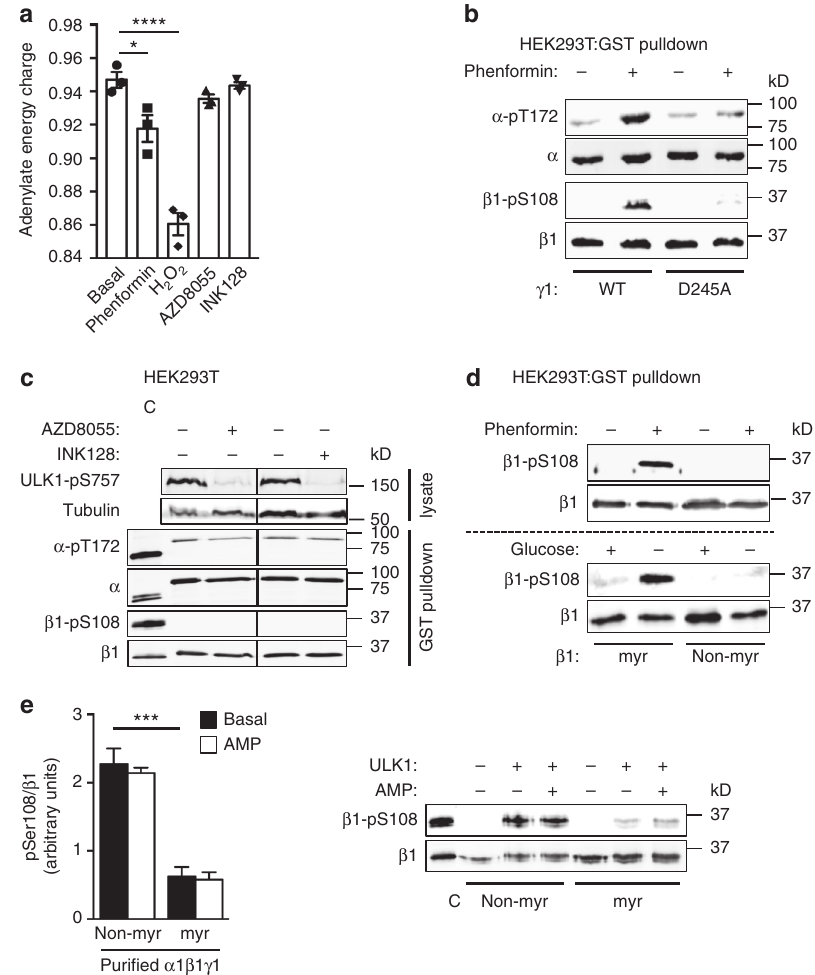
Fig. 7 An AMP-myristoyl switch triggers ULK1 phosphorylation of β 1-Ser108. a Adenine nucleotides extracted from HEK293T cells incubated with phenformin (2 mM, 1 h), H 2 O 2 (1 mM, 45 min), AZD8055 (1 μ M, 1 h), or INK128 (1 μ M, 1 h) were quantitated by mass spectrometry. Adenylate energy charge was calculated as described in Online Methods. n = 3. Error bars , mean adenylate energy charge ± s.e.m. Statistical analyses were performed using one-way ANOVA with post hoc Dunnett ’ s multiple comparison test. **** P > 0.001, * P < 0.05 indicate signi fi cant decrease in mean adenylate energy charge compared to basal. b Immunoblots for β 1-pSer108 and α -pThr172 in KI- α 1 β 1 γ 1 or KI- α 1 β 1 γ 1(D245A) puri fi ed from HEK293T cells stimulated with 2 mM phenformin for 1 h. n = 3, representative immunoblots shown. c Immunoblots for ULK1-pSer757, and β 1-pSer108 and α -pThr172 in KI- α 1 β 1 γ 1 puri fi ed from HEK293T cells incubated with 1 μ M mTOR inhibitors AZD8055 or INK128 for 1 h. n = 3, representative immunoblots shown. C: Bacterial expressed, CaMKK2-treated α 1 β 1 γ 1 standard. d Immunoblots for β 1-pSer108 in KI- α 1 β 1 γ 1 (myr) or KI- α 1 β 1(G2A) γ 1 (non-myr) puri fi ed from HEK293T cells